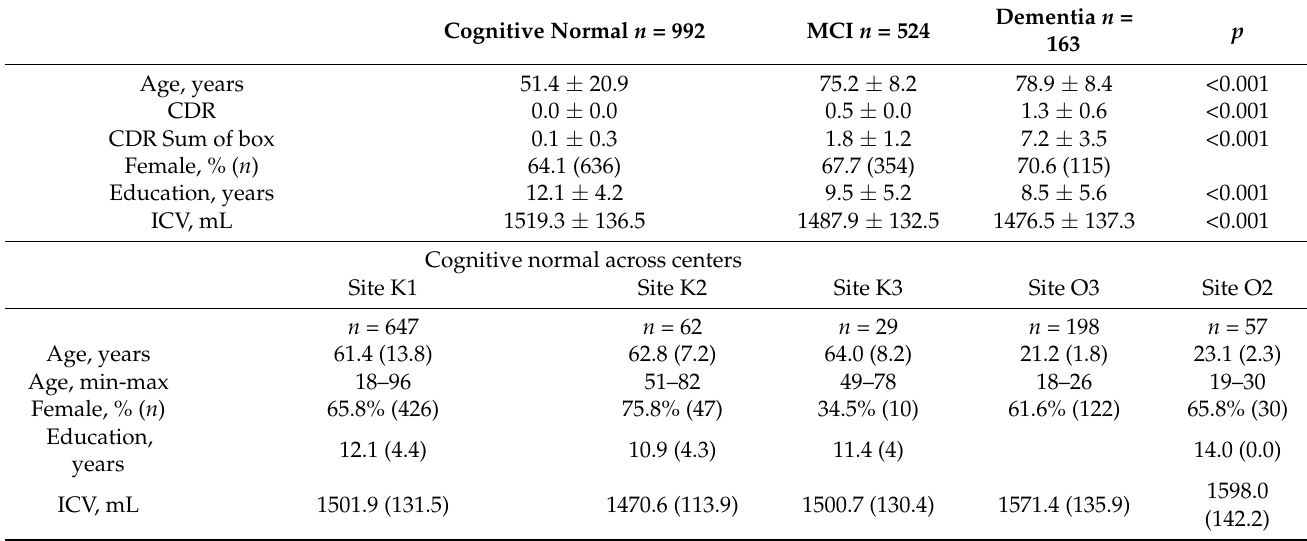
Table 1. Participants description for cognitive normal brain ages from 18 to 96